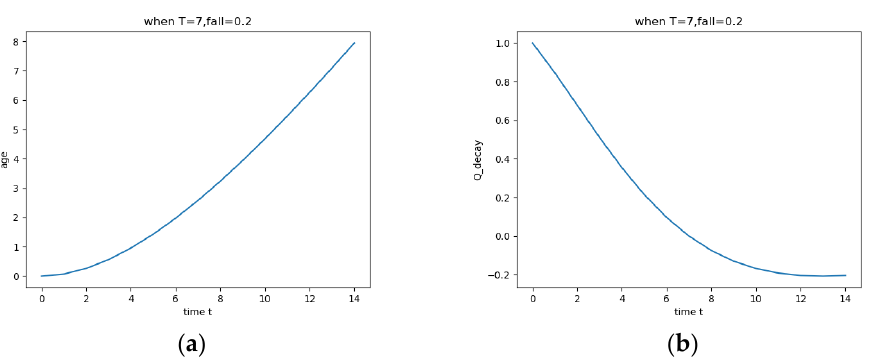
Figure 2. Trend of expected 𝑎𝑔𝑒 and timeliness score of data with 𝑡 ( 𝑇 = 7 ).